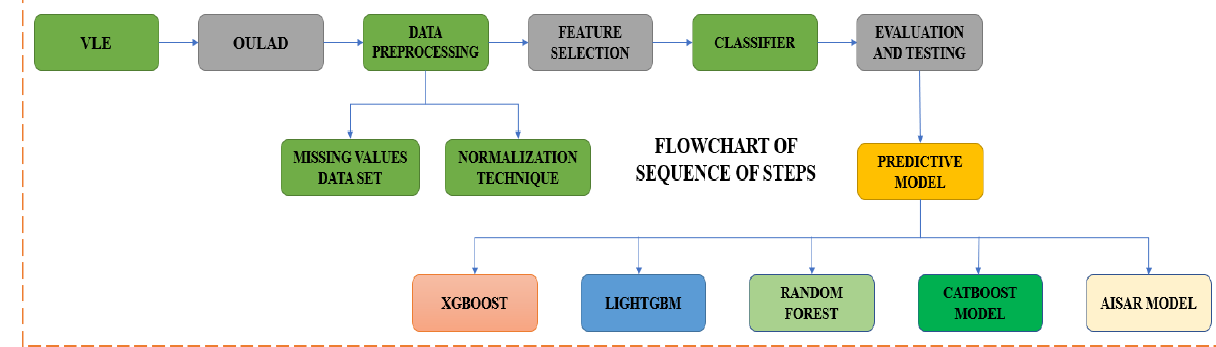
Figure 6. Flowchart of Sequence of Steps.